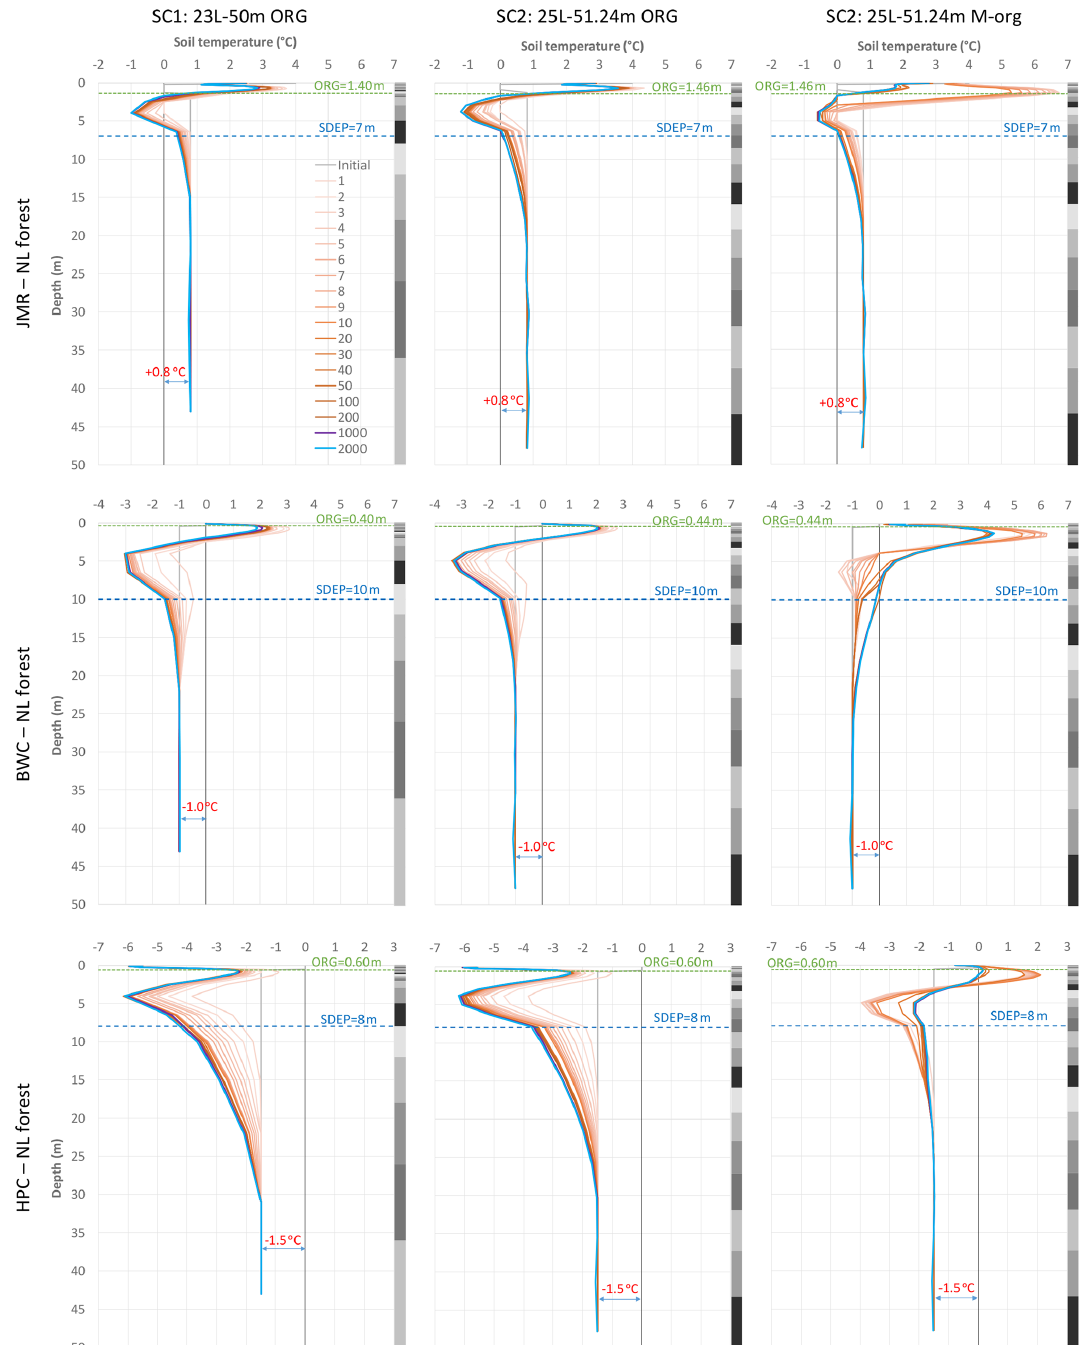
Figure 5. Soil temperature profiles at the end of selected spin-up cycles for the NL forest GRU at all three sites using different soil layering schemes and organic configurations; grey bars on the side indicate soil